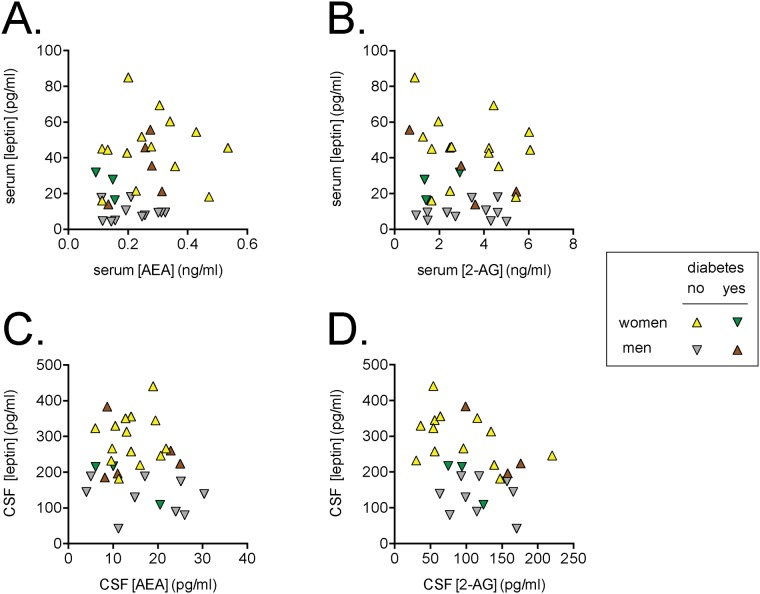
Relationship between endocannabinoid and leptin levels in the serum (A, B) and CSF (C, D).Shown are the data for AEA (Panels A, C) and 2-AG (Panels B, D). The Spearman ρ values are provided in Table 2.